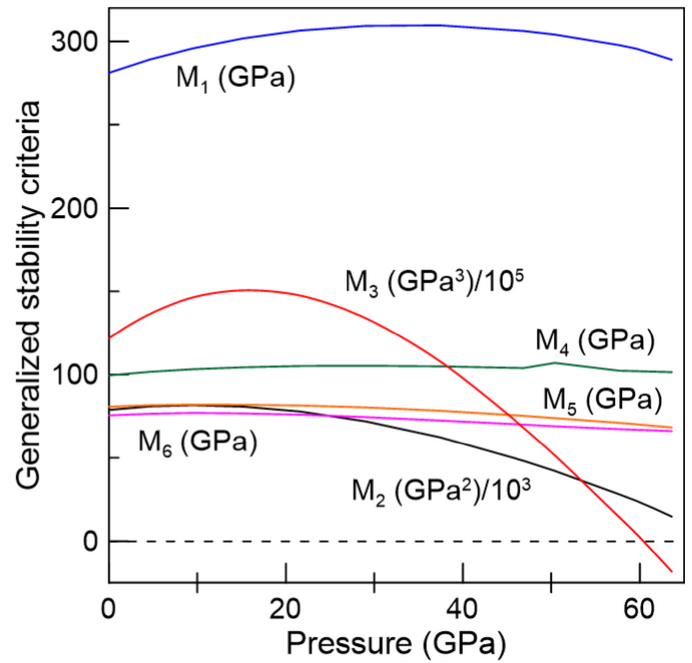
Figure 9. Generalized stability criteria as a function of pressure for DyScO 3 perovskite.